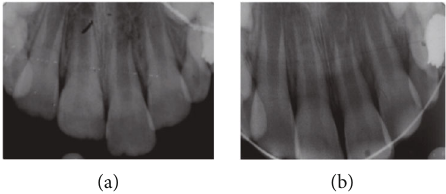
Figure 1: (a) Initial periapical radiograph. (b) Radiographic examination after repositioning is